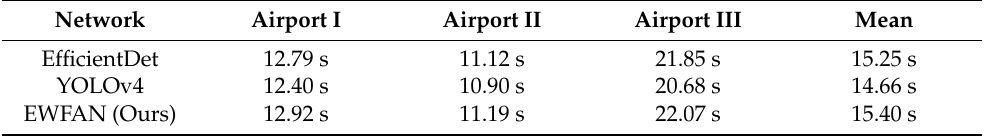
Table 8. Comparison of the test time from SAR images of different network (with airport mask algorithm). Network